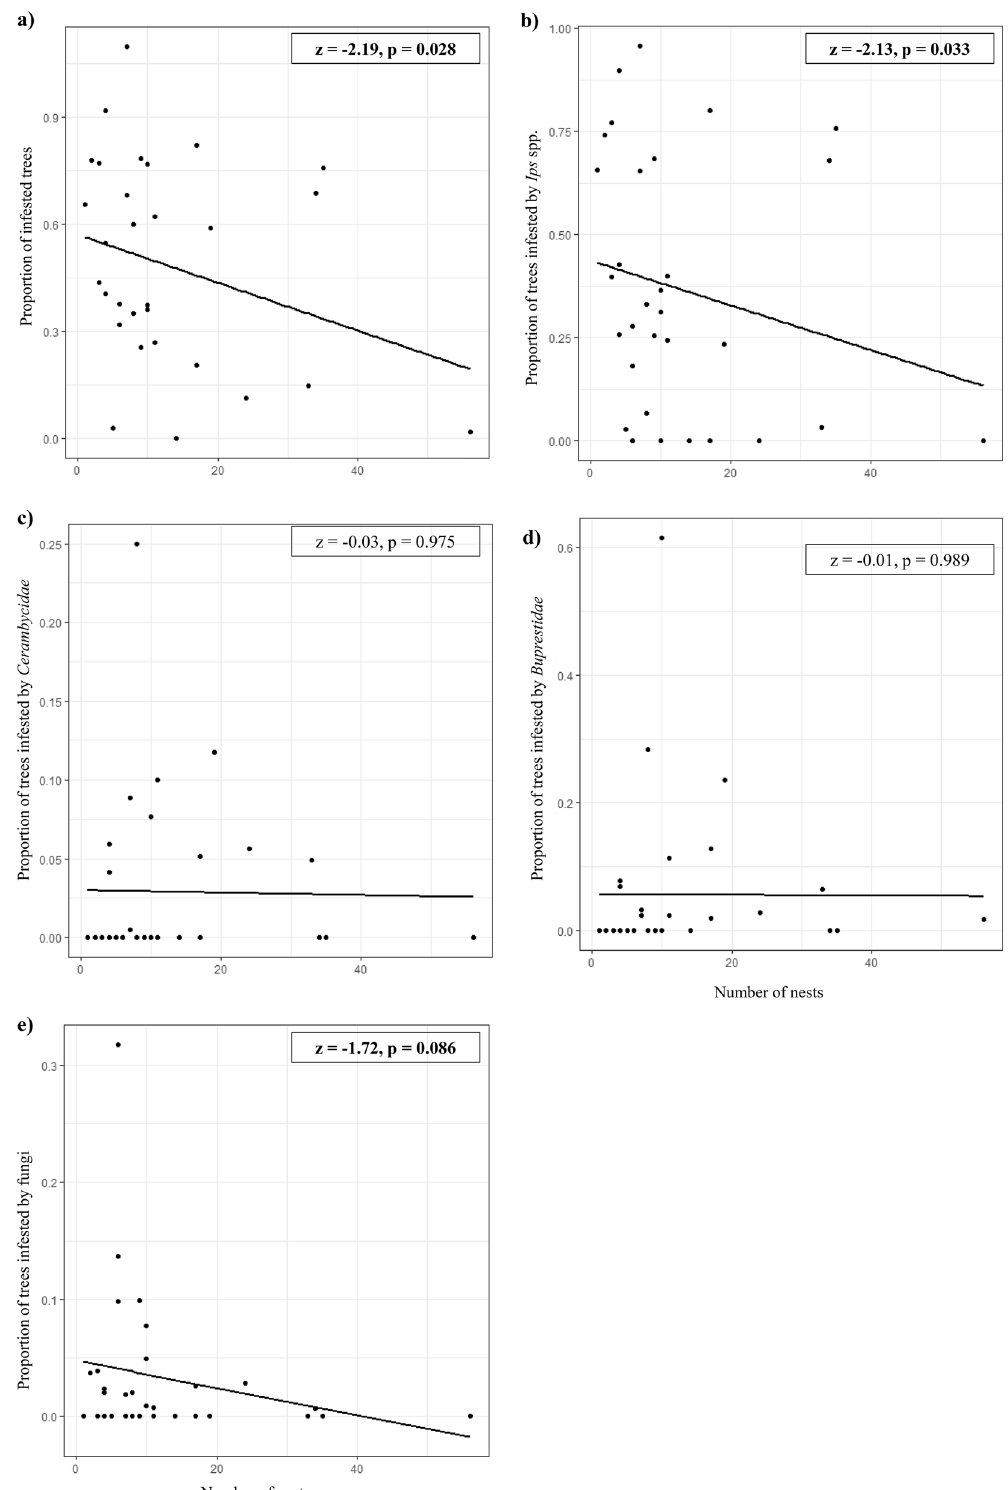
Figure 2. Scatterplot with fitted regression line illustrating the relationship between the number of F. polyctena nests and the proportion of infested trees by ( a ) all the studied pest groups, and separately for ( b ) bark beetles ( Ips spp.), ( c ) boring beetles of the Cerambycidae group, ( d ) boring beetles of the Buprestidae group, and ( e ) fungi. Significant results are with bold